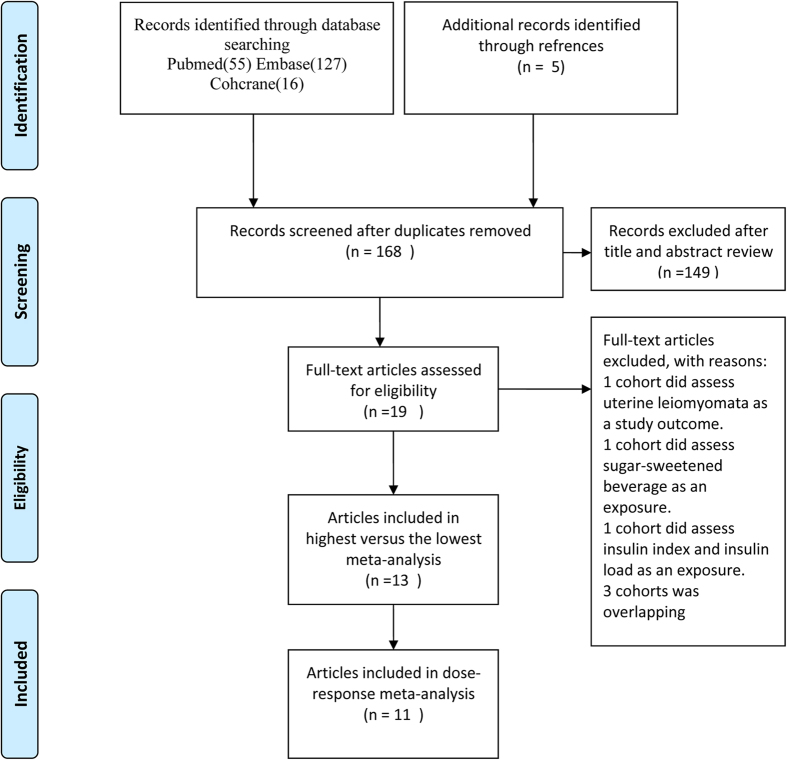
Flowchart of literature search and study selection.